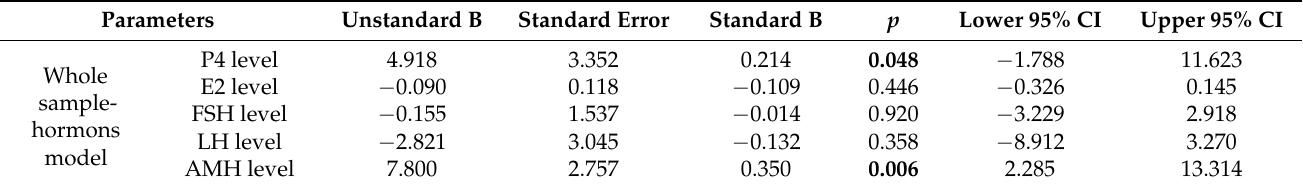
Table 5. Multivariable regression of the relationship between P4 levels and the implantation